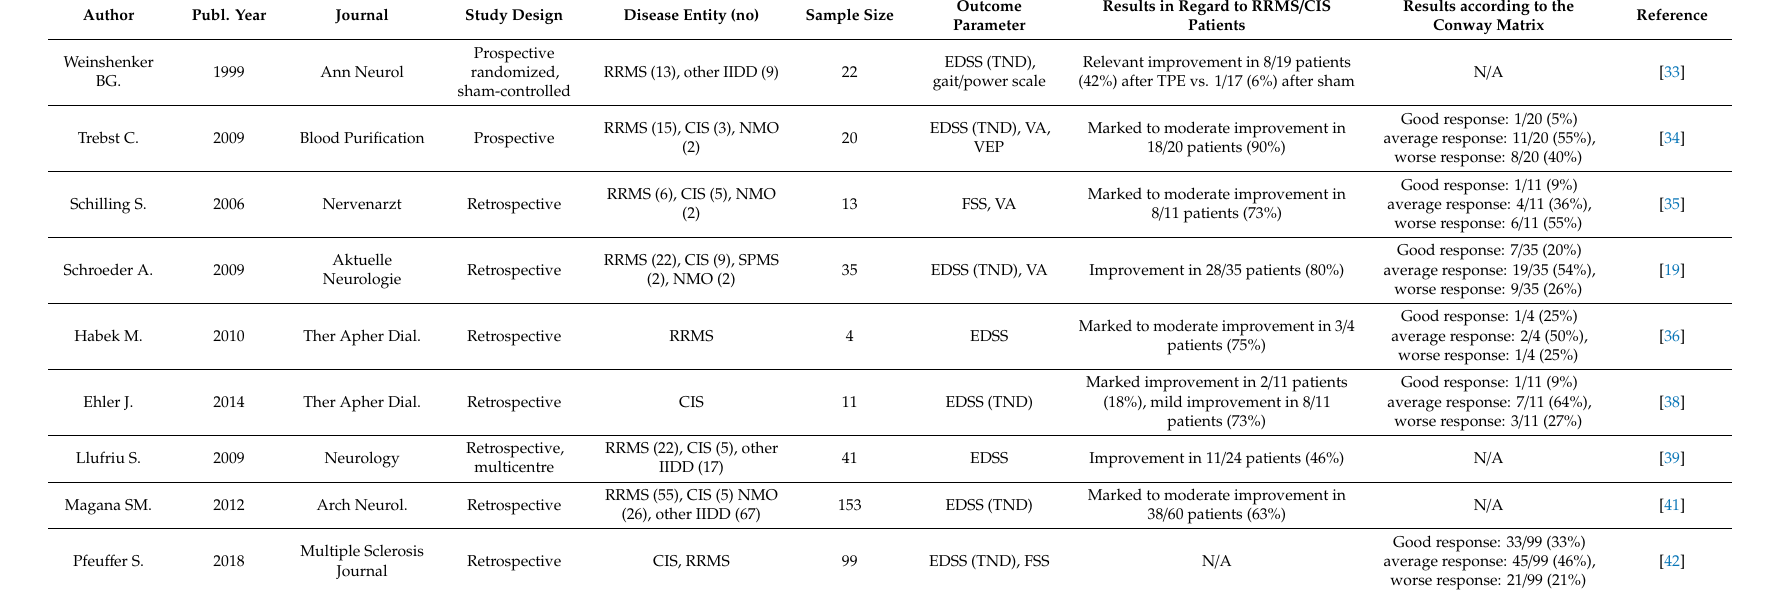
Table 2. Overview of publications on therapeutic plasma exchange in acute MS